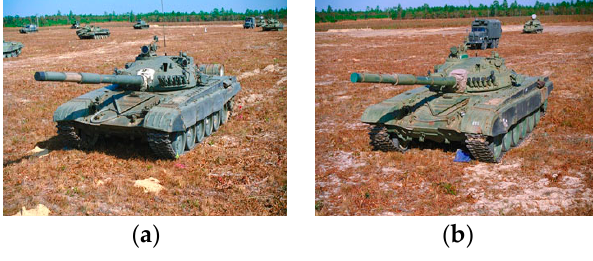
Figure 1. Two configurations of the T72 tank: ( a ) A04; and ( b ) A05.